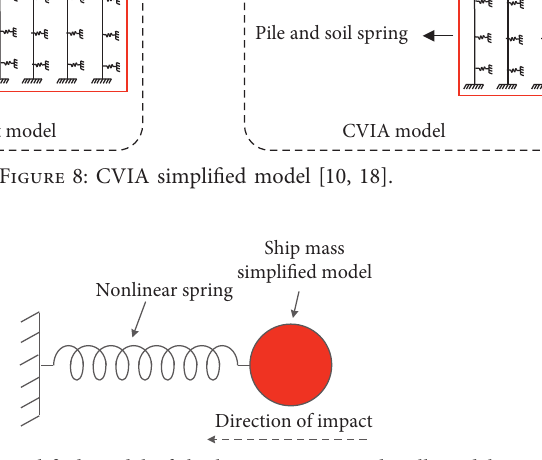
Figure 10: Model of barge